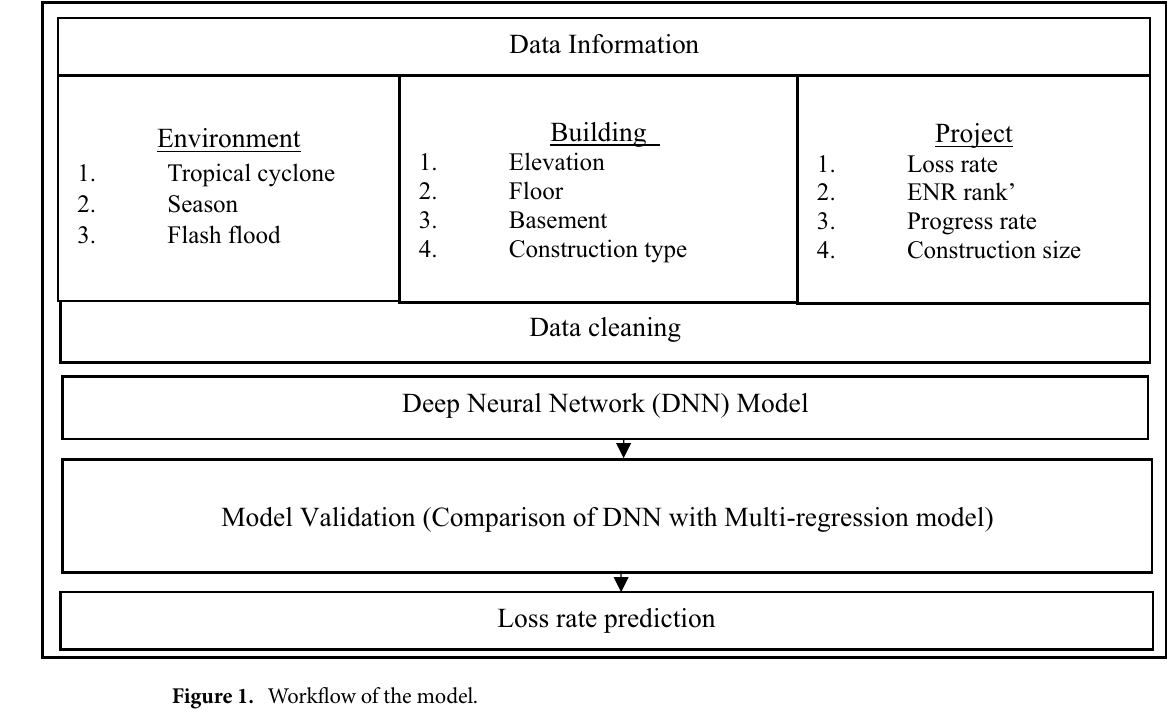
Figure 1. Workflow of the